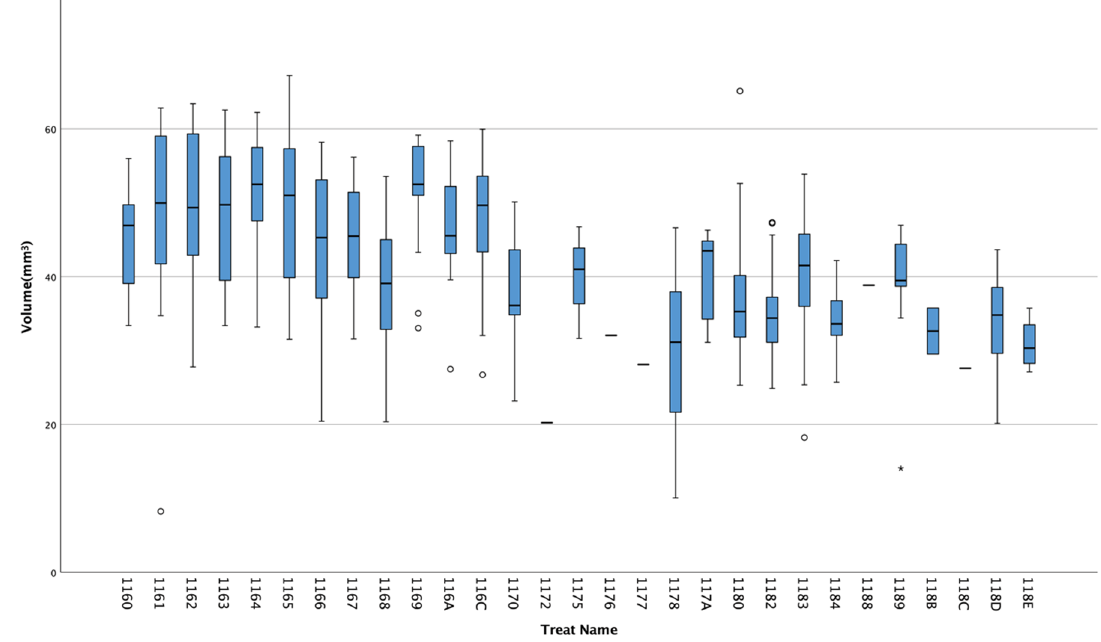
Figure 23. The volume distribution of grains in 43 groups of spikes; the black short line means average value of the spike. The volume distribution of all wheat spikes please refer to Additional file II: All Spike Volume.pdf.